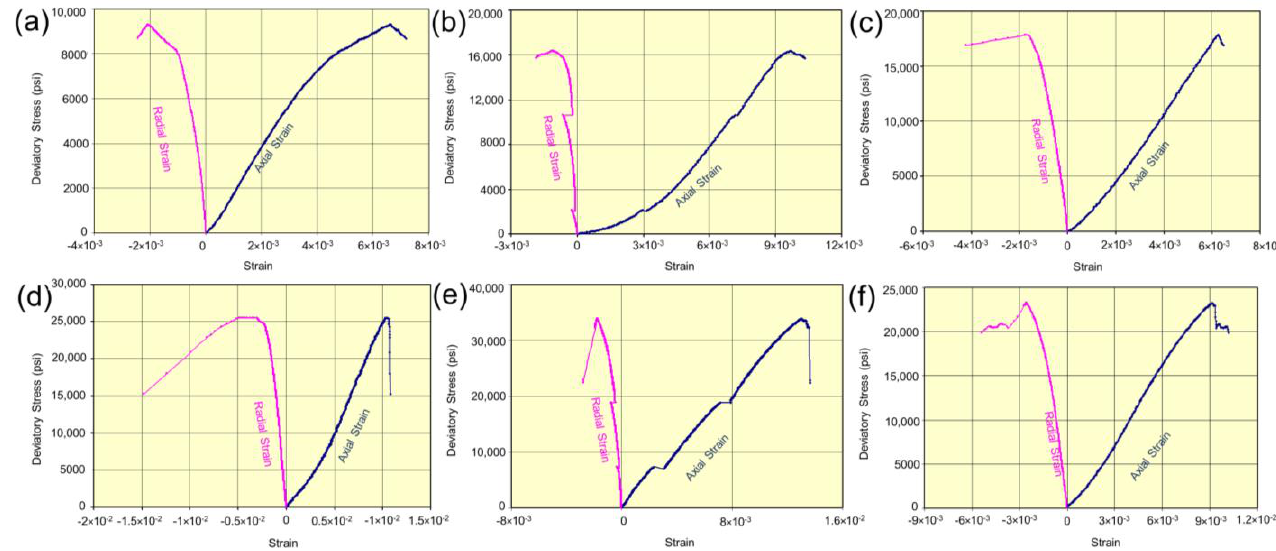
Figure 12. Measurements of the triaxial compression tests for coring wells. ( a – c ) Measurements for well 4-2-62-23. ( d – f ) Measurements for well 16-33-62-24. Table 1. Statistics of the geomechanical measurements with vertical direction for coring wells.